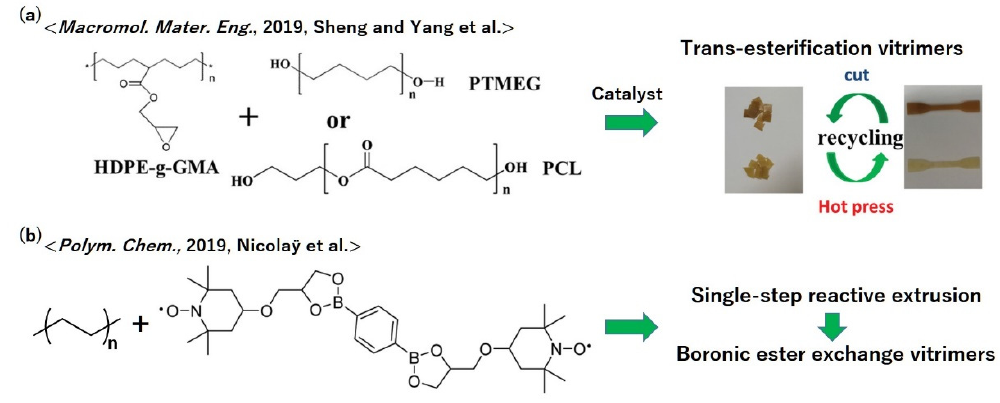
Figure 15. Molecular designs of vitrimer polyethylenes according to ( a ) ref. [65] and ( b ) ref. [66]. Please also see the bond exchange mechanism of boronic ester exchange in Figure 13. ( a ) Reprinted with